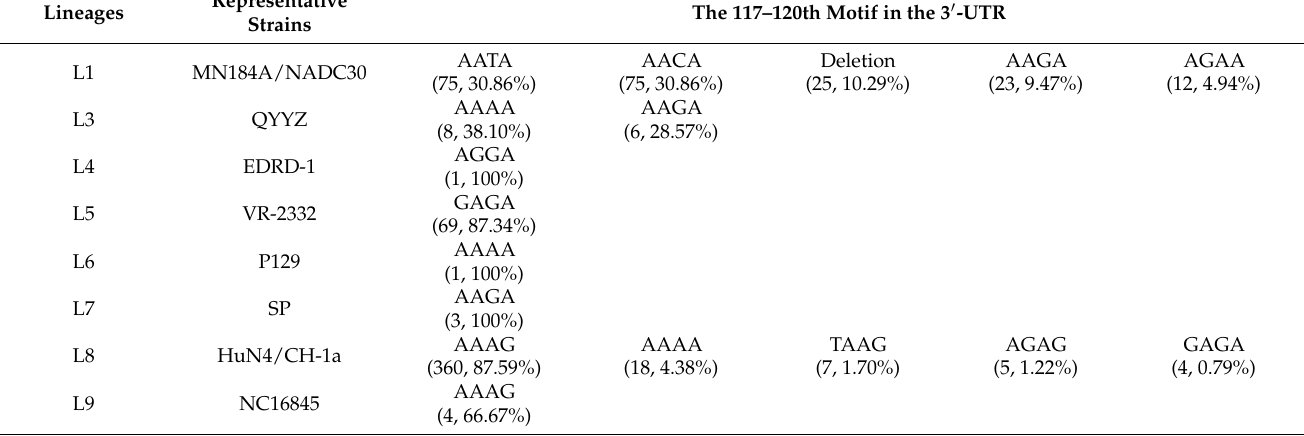
Table 2. Mutations of the 117–120th motif in different PRRSV lineages. L1 includes five mutation patterns: AATA (represented by MN184A), AACA (represented by NADC30), AAGA, AGAA and deletion at position 118–120th. L3 includes two mutation patterns: AAAA and AAGA. L8 includes five dominant mutation patterns: AAAG (represented by HuN4), AAAA, TAAG, AGAG and GAGA (represented by CH-1a).